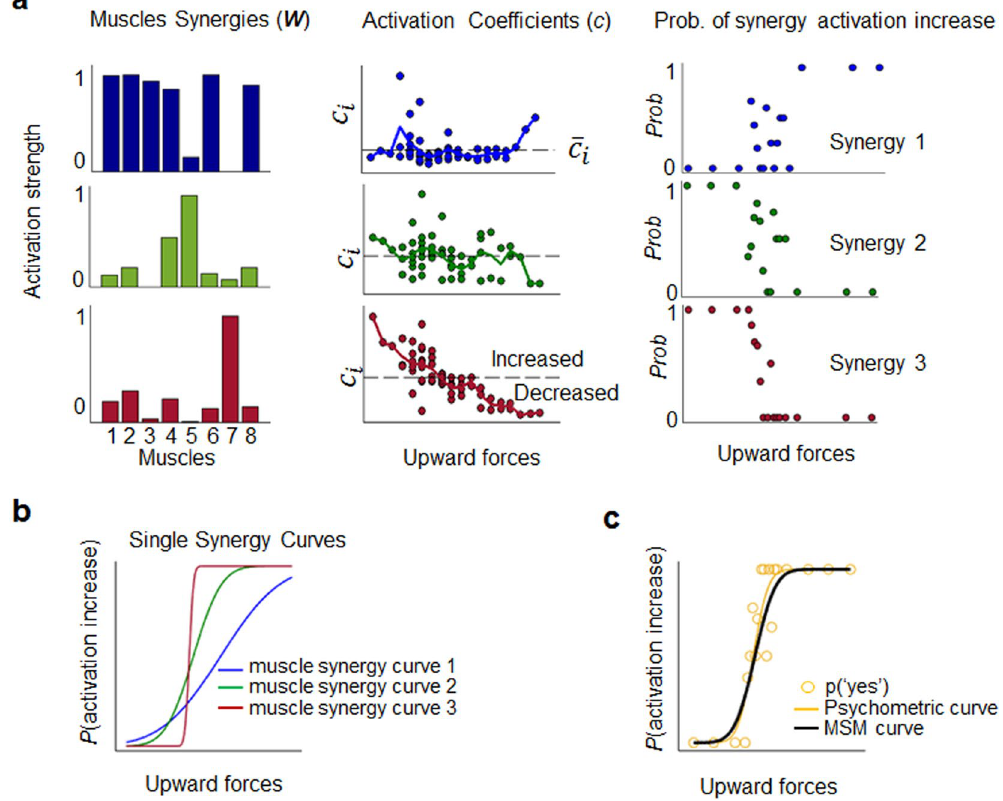
Figure 2. Synergy extraction and force-related synergy identification. ( a ) Least number of muscle synergies (W) and associated activation coefficients c that account for 90% of the EMG total variance (i.e., task related synergies) of a representative participant (i.e., subj 1). Left plots: Activation strength of the muscle synergies extracted from eight arm muscles: brachioradialis (1), biceps brachii (2), triceps brachii (3), trapezius middle (4) and upper (5), latissimus dorsi (6), deltoid anterior (7) and posterior (8). Middle plots: each dot describes the amount of activation c of the synergy i as function of the external upward force. Multiple dots associated to the same upward force represents different trials with the same force intensity. The horizontal dashed line indicates the mean value of the distribution of the activation coefficient across all trials for each synergy ( C ). At each trial i < . Right plots: t , each synergy activation was classified as increased when > C C , or decreased when C C it i it i Dots represent the across-trials probabilities of each external force to elicit an activation increase of the synergy i . ( b ) Individual synergy curves (GLMM output) relating the probabilities of each synergy activation increase/ decrease as a function of force stimuli. For each curve, slope values quantify the amount of modulation of the muscle synergy as function of force stimuli. c ) GLMM overall predicted probabilities of activation increase (black curve) of the subset of muscle synergies showing statistical significant modulation with respect to force stimuli. Overall muscle-synergy -i.e., MSM - curve was obtained through an iterative procedure identifying and excluding, at each iteration, the synergy modules not significantly related or weakly encoding force stimuli (see Force-related synergy identification and MSM curve , Methods). In this example, the overall muscle-synergy curve is drawn by the GLMM analysis combining synergy 2 and 3 probabilities of activation increase, synergy 1 being excluded (see details in Force-related synergy identification and MSM curve , Methods). Yellow circles and curve denote probabilities of a ‘yes’ answer and the psychometric curve, respectively, describing participants’ perceptual behavior as function of the applied force (GLM probit